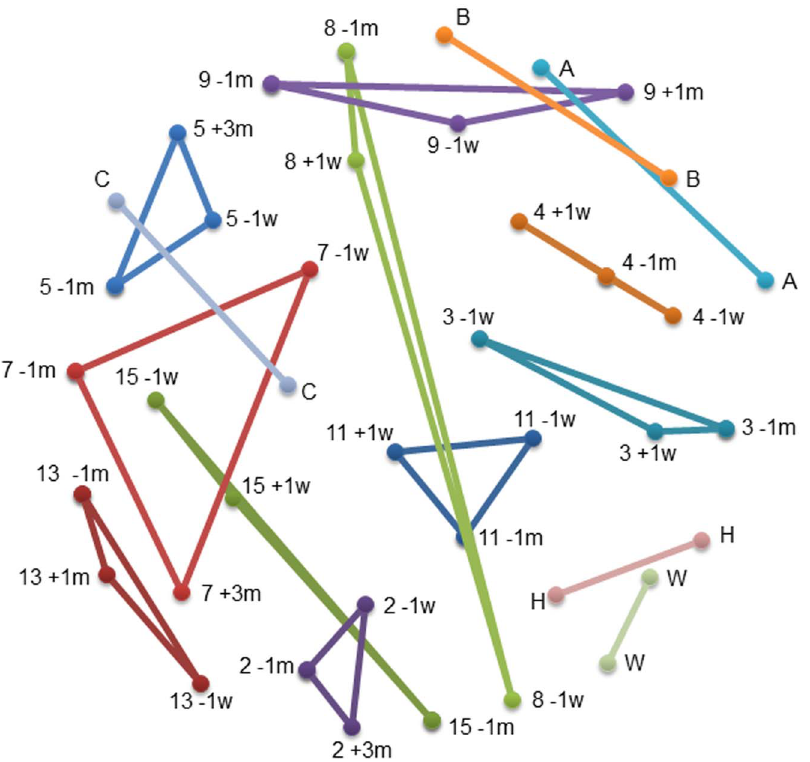
Figure 2. NMDS plot of the microbial communities of subjects’ samples using a distance matrix calculated with the Jaccard similarity coefficient. The plot of the two NMDS axes was generated using a distance matrix calculated at the 3% level, with the Jaccard similarity coefficient within Mothur for all samples. The distance between two points is directly proportional to the Jaccard similarity value for two samples such that sites positioned close together share more OTUs than samples further apart. NMDS stress=0.15. Refer to Figure 1 legend for sample labelling.